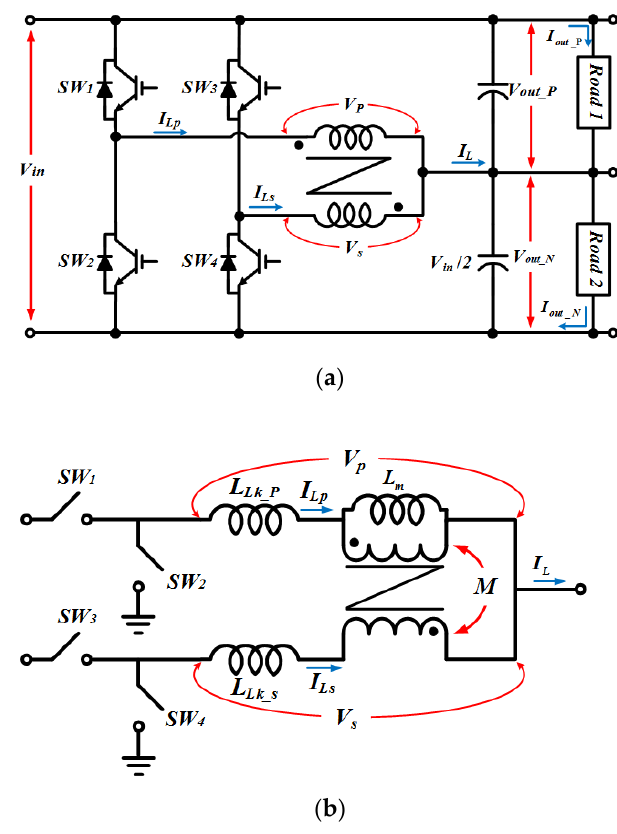
Figure 3. Configuration of DC microgrid with VB and coupled inductor (CI): ( a ) Proposed VB; ( b ) equivalent schematic of two-phase CI.